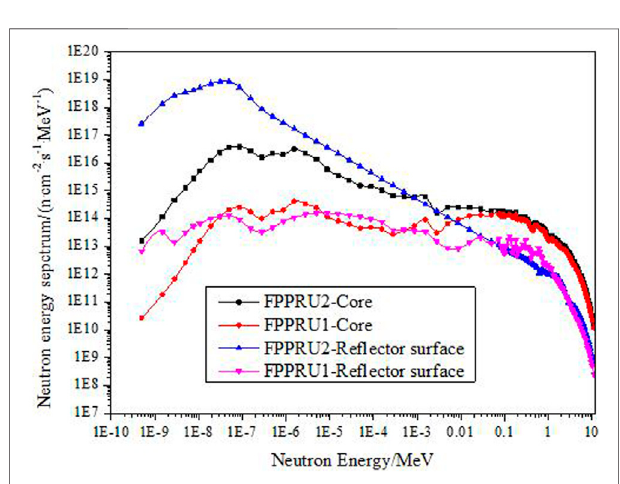
FIGURE 6 | Maximum effective multiplication factor k eff vs. the enrichment of U-235.